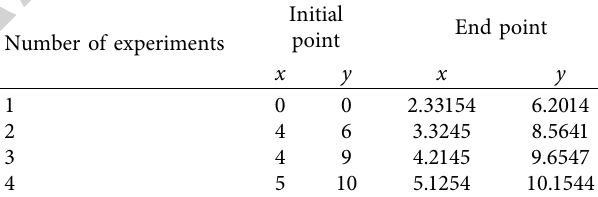
Table 2: The positions of the initial and ending points in the